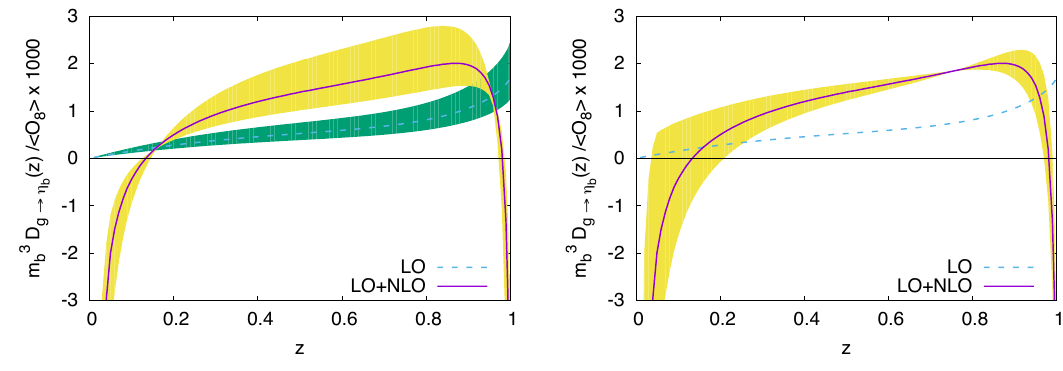
Figure 5 . The color-octet 1 S 0 contribution to the fragmentation function D g ! (cid:17) NLO. The curves are the LO fragmentation function (dashed line) and the sum of the LO and NLO terms in the fragmentation function (solid line) for the scale choices (cid:22) R = (cid:22) F = 2 m b . The bands are obtained by varying the renormalization scale (cid:22) R by a factor of 2 (left panel) and varying the factorization scale (cid:22) F by a factor of 2 (right